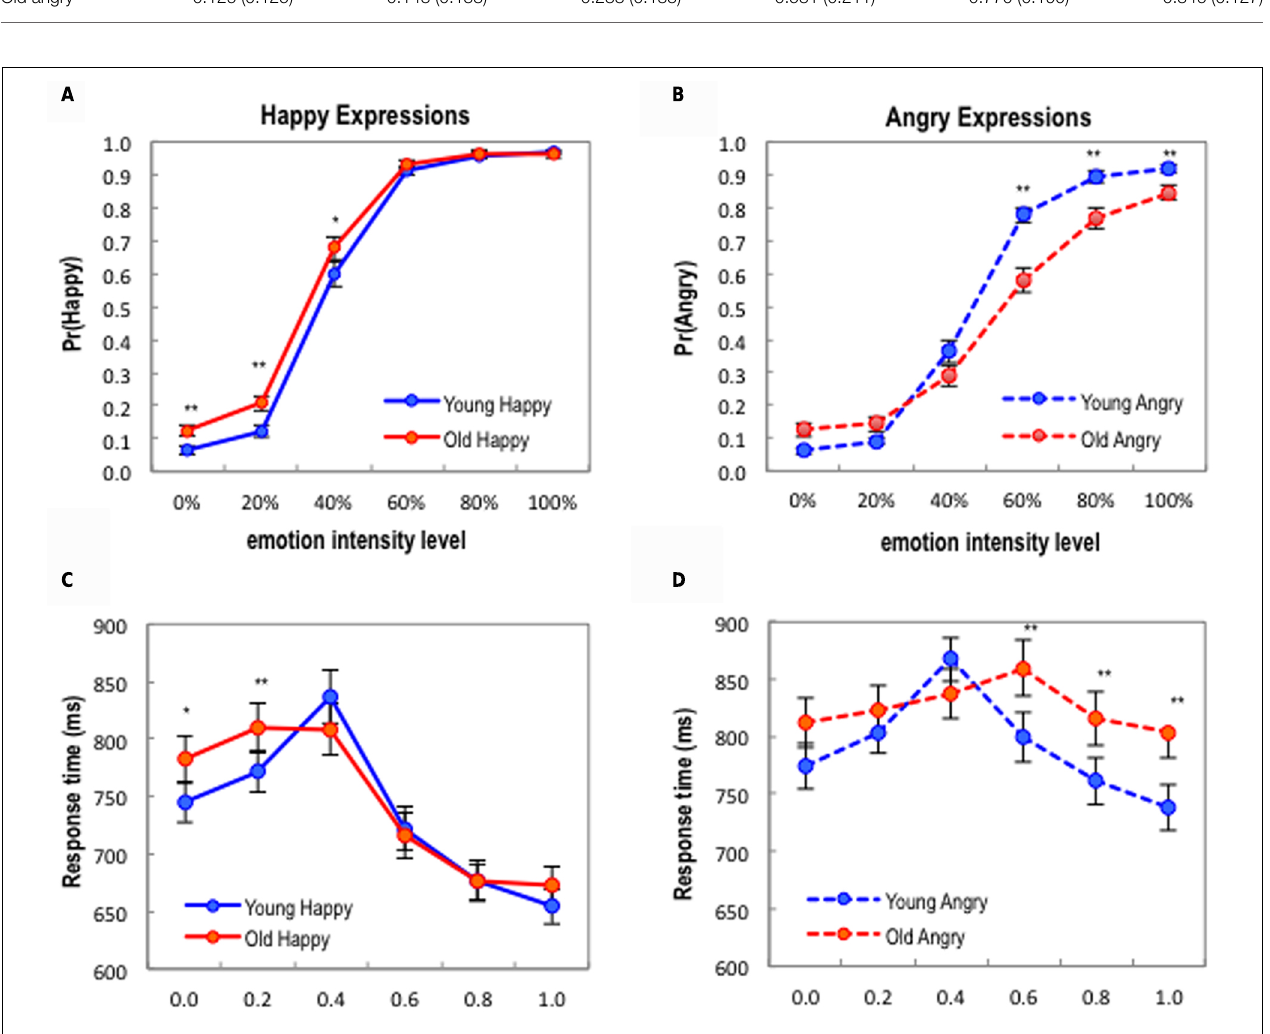
decisions. (D) Response times of angry decisions. Error bars denote the standard error of the mean. * p < 0.05; ** p < 0.01 (Bonferroni corrections